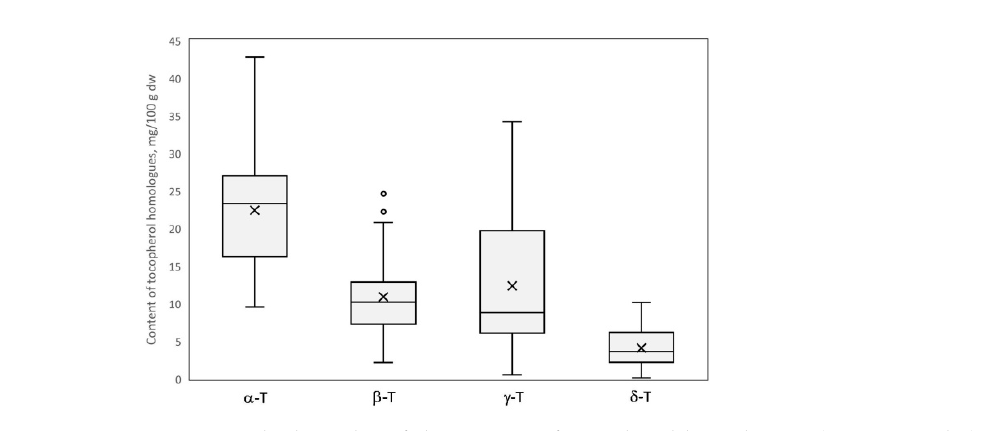
Figure 2. The box-plot of the content of tocopherol homologues ( α , β , γ , and δ ) in thirty crab apple genotypes.